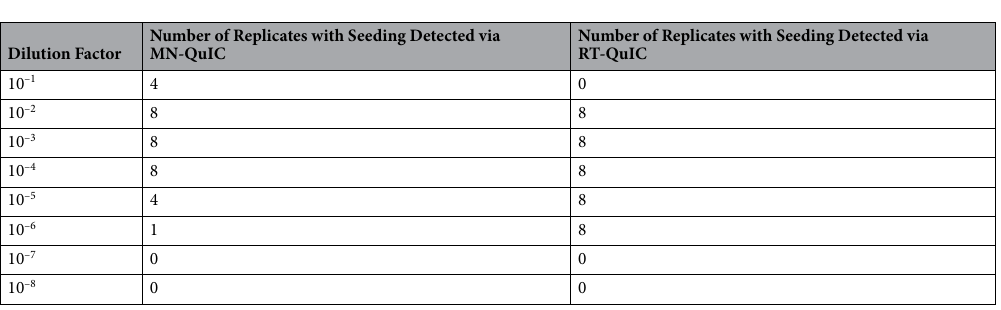
Table 2. Serial dilution: Dilutions of CWD positive parotid lymph node run for 24 h via MN-QuIC vs 24 h via RT-QuIC.